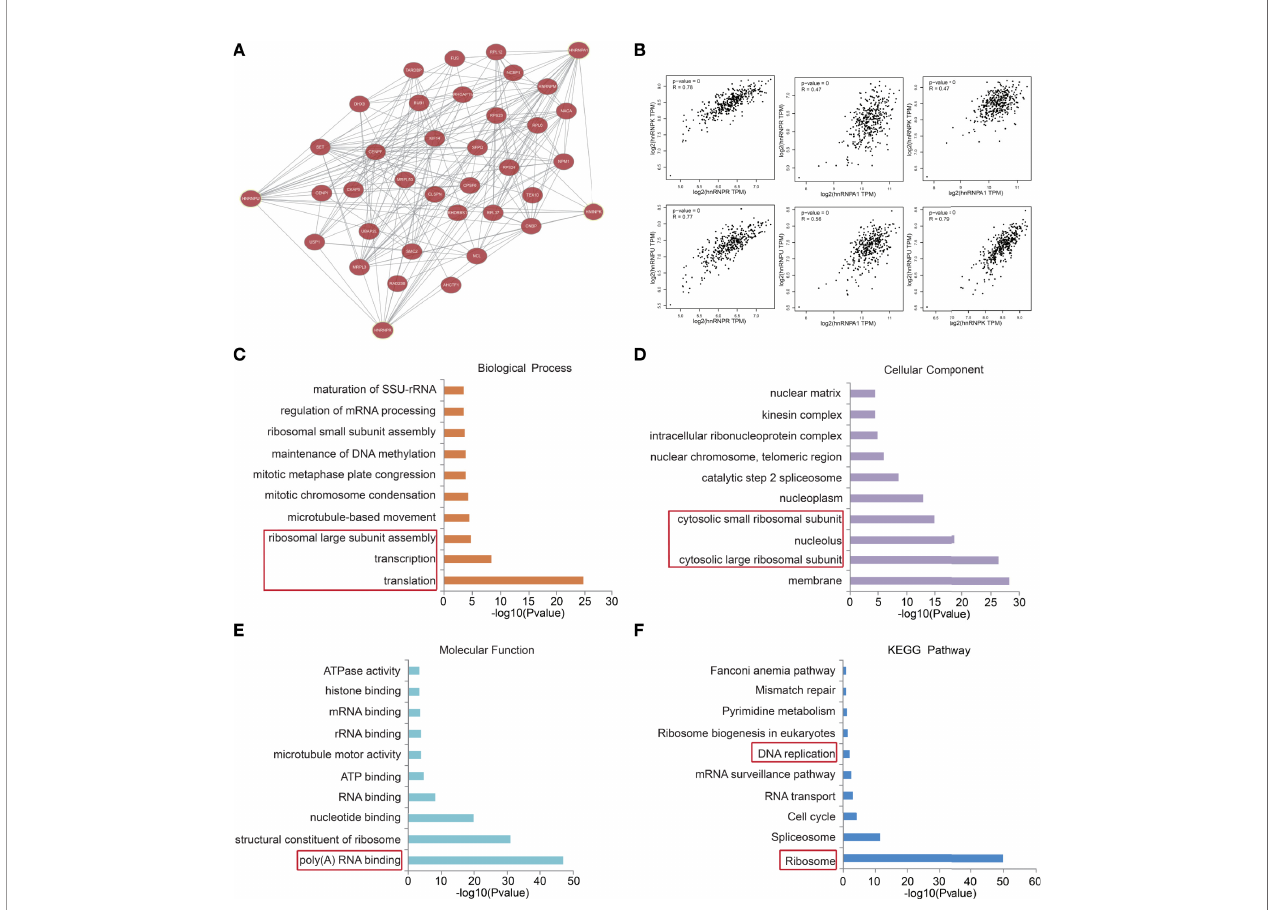
FIGURE 5 | The hnRNPK/A1/R/U network in colorectal adenocarcinoma modulated transcription and translation. (A) A gene co-expression network for hnRNPA1, hnRNPK, hnRNPR, and hnRNPU was constructed. The network displayed that the transcription-related and translation-related genes, such as DHX9, MRPL3, SFPQ, CPSF6, RAD23b, and NCBP1, were closely associated with the hnRNPK/A1/R/U network. (B) The GEPIA database revealed that the TPM levels of hnRNPK/ A1/R/U with each other were positively correlated. (C, D, E, F) The functional predictions of hnRNPK/A1/R/U network were analyzed in the DAVID database. The GO analysis results showed that transcription, translation, and ribosomal large subunit assembly were regulated by the hnRNPK/A1/R/U. Furthermore, ribosomal subunit, nucleotide binding, structure constituent of ribosome, and poly(A) RNA-binding were also enriched. The KEGG analysis results showed that DNA replication and ribosomes were enriched, suggesting that hnRNPK/A1/R/U modulated the process of transcription and